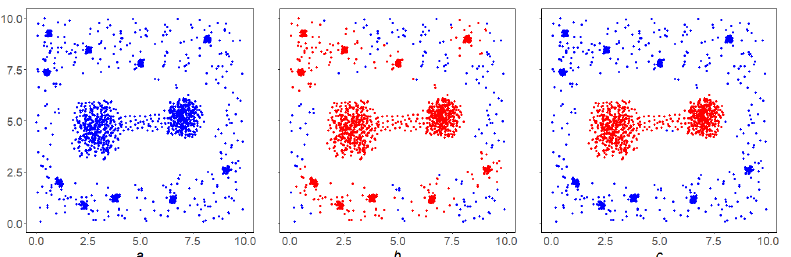
Figure 10. An illustration of the independence of the MDPS and SDPS algorithms: the “dumbbell” in the original array ( a ) has a sparse handle, which MDPS highlights cleanly ( c ); SDPS cannot do this ( b ).